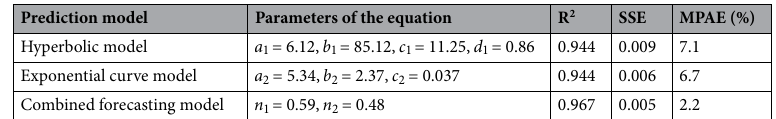
Table 6. Cumulative differential settlement prediction model of monitoring point 5.